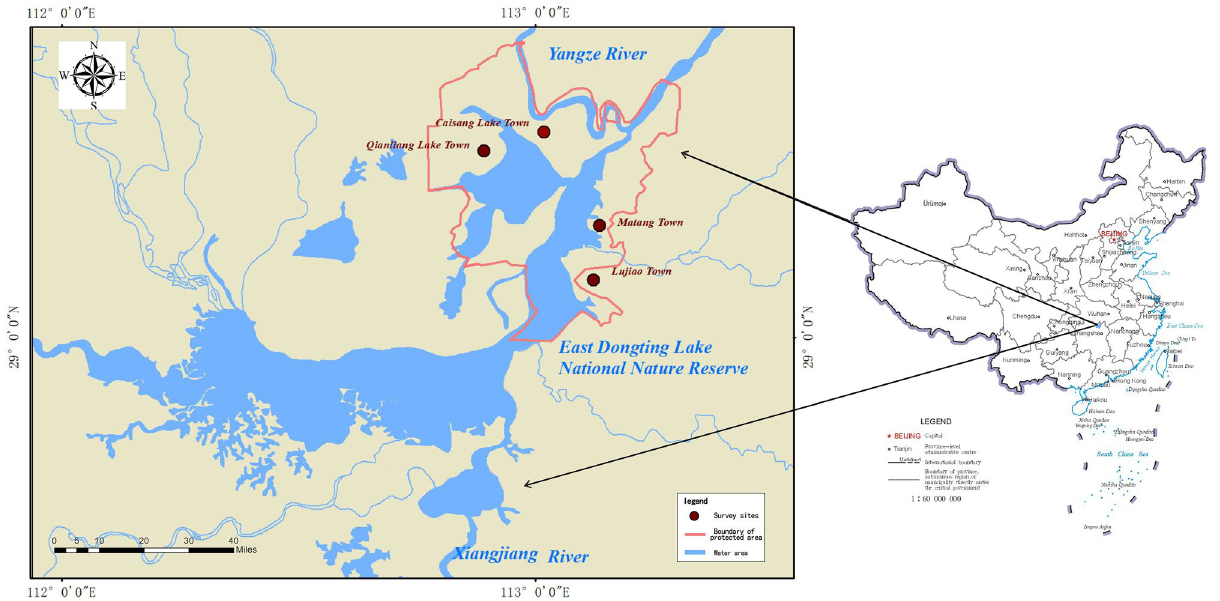
Figure 1. Study area: East Dongting Lake National Nature Reserve; Brown dots show four investigation points and the red line shows the boundary of the protected areas. (Created with ArcGIS Pro3.02; https:// www. esri. com/ en- us/ arcgis/ produ cts/ arcgis- pro/ overv